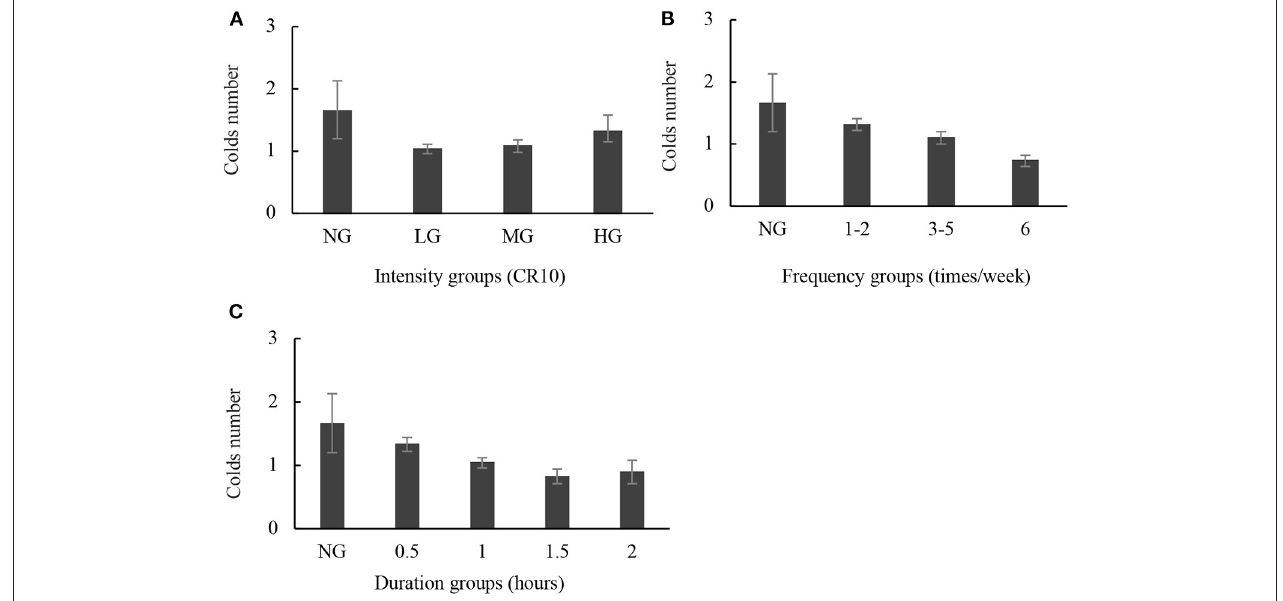
FIGURE 2 | Associations of intensity, frequency, and duration with the number of colds in the last year. (A) Intensity with colds, (B) frequency with colds, and (C) duration with colds. The abscissa represents frequency (times/week) or duration (hours). Data are presented as mean ± 95% CI with P -value < 0.05.